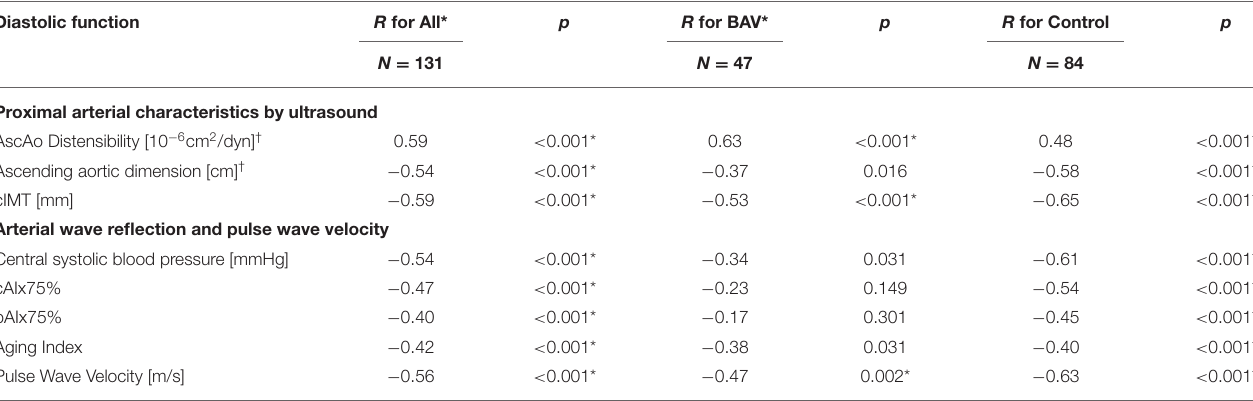
TABLE 5 | Correlations between average E’ (diastolic function) and cardiovascular characteristics for all patients as well as group-wise analysis for controls and BAV patients. Diastolic function R for All* p R for BAV* p R for Control